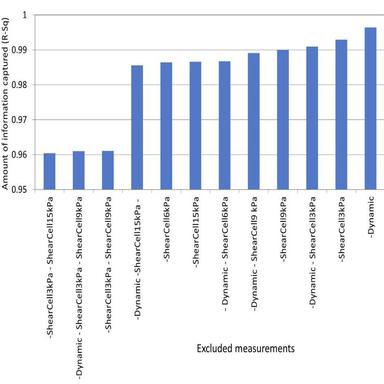
Identified reduced set of measurements that capture more than 95% of information.